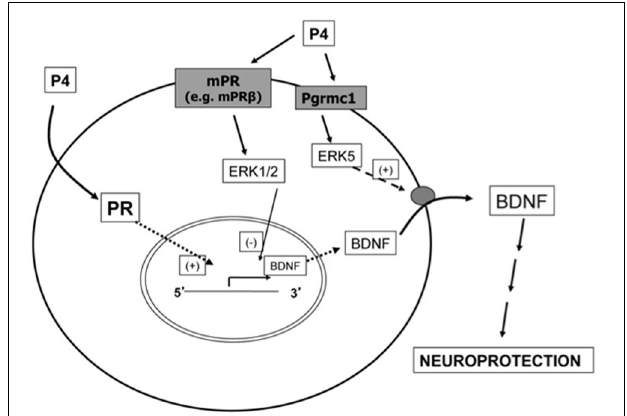
FIGURE 1 | Mechanism of progesterone action in the brain. This figure provides a conceptual overview of how progesterone can elicit both genomic and non-genomic effects that impact its protective effects on the brain, and exemplifies how activation of complementary signaling cascades may be required for progesterone to fully elicit its effects. Using BDNF and two members of the ERK/MAPK family as paradigmatic examples of key mediators of progesterone-induced neuroprotection, this diagram underscores the fact that the protective effects of progesterone cannot be elicited by one signaling pathway alone, but rather, require complementary activation of multiple signaling pathways. In this example, the induction of BDNF synthesis requires the PR operating through its classical, genomic mechanism of action. However, such synthesis may not be meaningful unless the cellular content of BDNF can be secreted, leading in turn to the activation of its cognate receptors (ex. TrkB and/or p75) which can then elicit additional signaling pathways associated with cellular protection. This release of BDNF is mediated by a distinct receptor, Pgrmc1. In addition, other membrane-associated progesterone receptors, such as the mPR family of receptors, may elicit the activation of related signaling pathways that help finely regulate the process. In the example illustrated, activation of mPR may lead to activation of ERK1/2, which in turn, has been shown to exert an inhibitory influence on BDNF gene